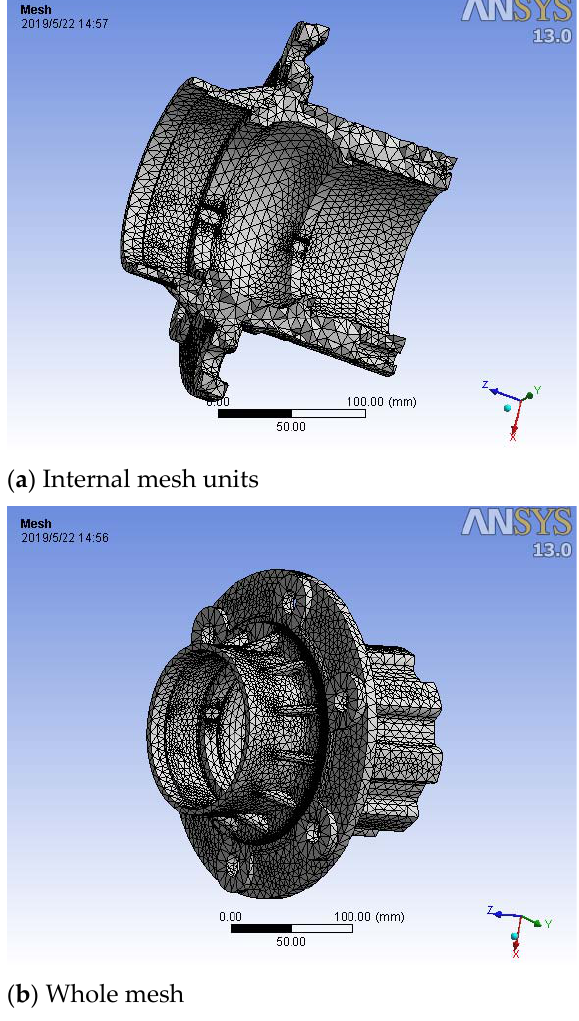
Figure 5. Meshing model of the wheel hub.